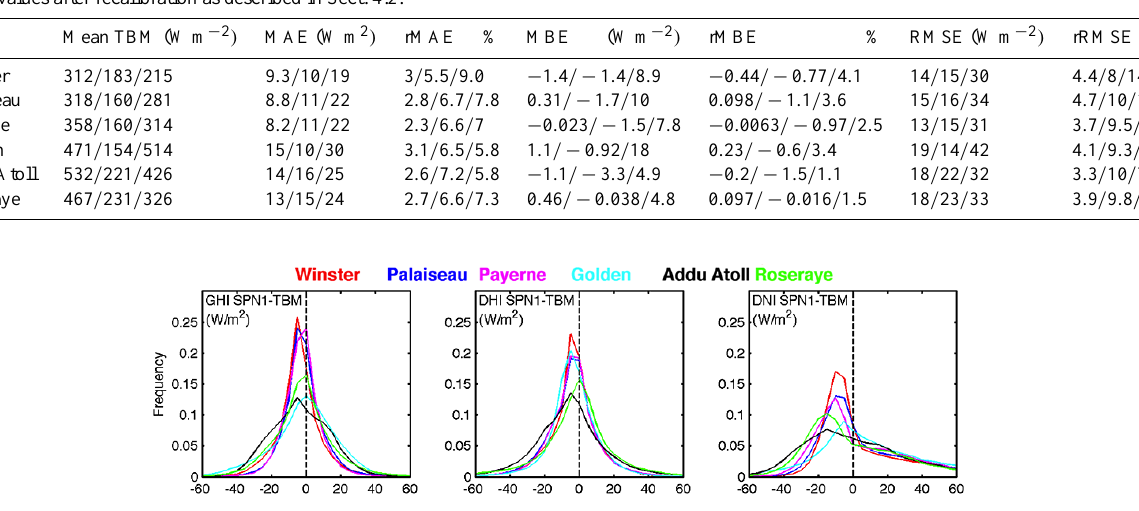
Figure 3. SPN1 – TBM difference distributions (after slope calibration) for GHI (left), DHI (centre) and DNI (right) irradiance at all